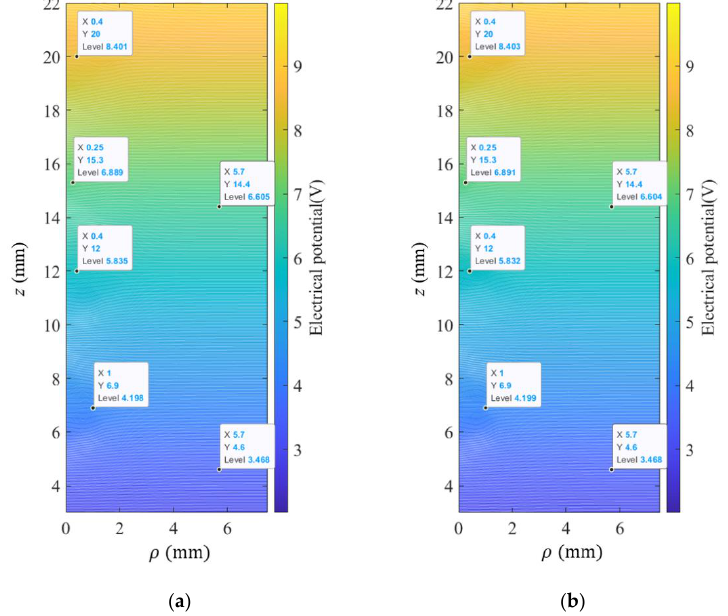
Figure 10. Electric potential distribution of bubbles in liquid nitrogen. ( a ) CFEM, ( b ) XFEM.